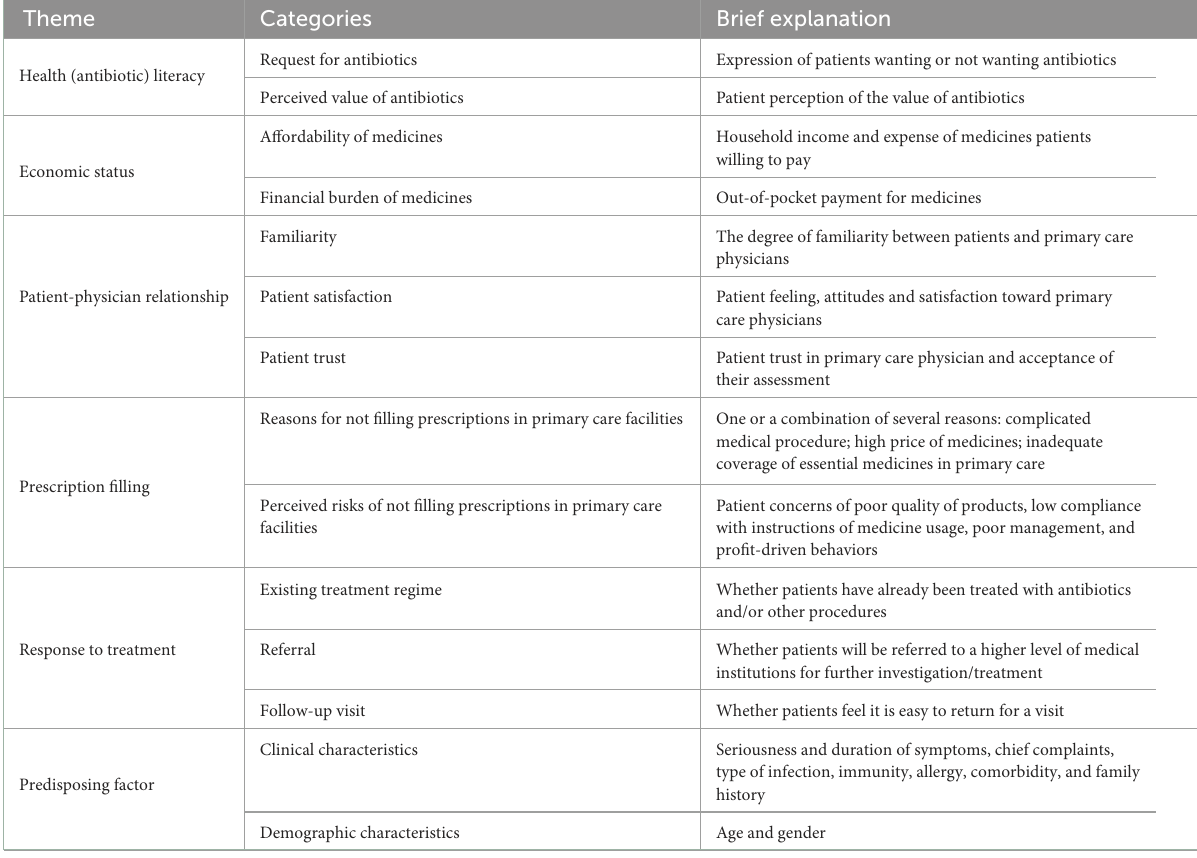
TABLE 1 Patient attributes associated with antibiotic prescribing for upper respiratory tract infections in primary care ∗ .